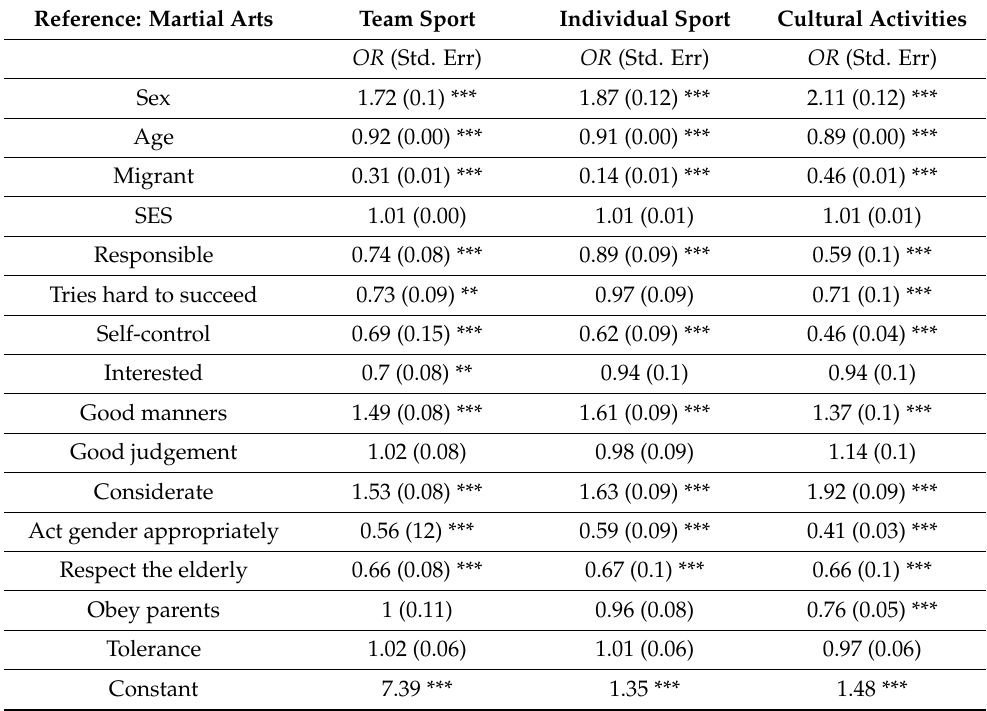
Table 2. Predicting group membership by demographics, desirable traits and parents’ levels of tolerance with martial art as reference group.